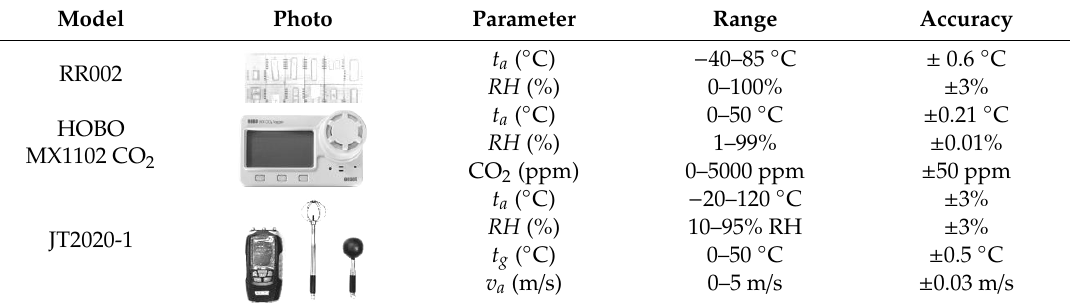
Figure 5. Layout of the measuring points in the classroom. Table 2. Technical specifications of the instruments.